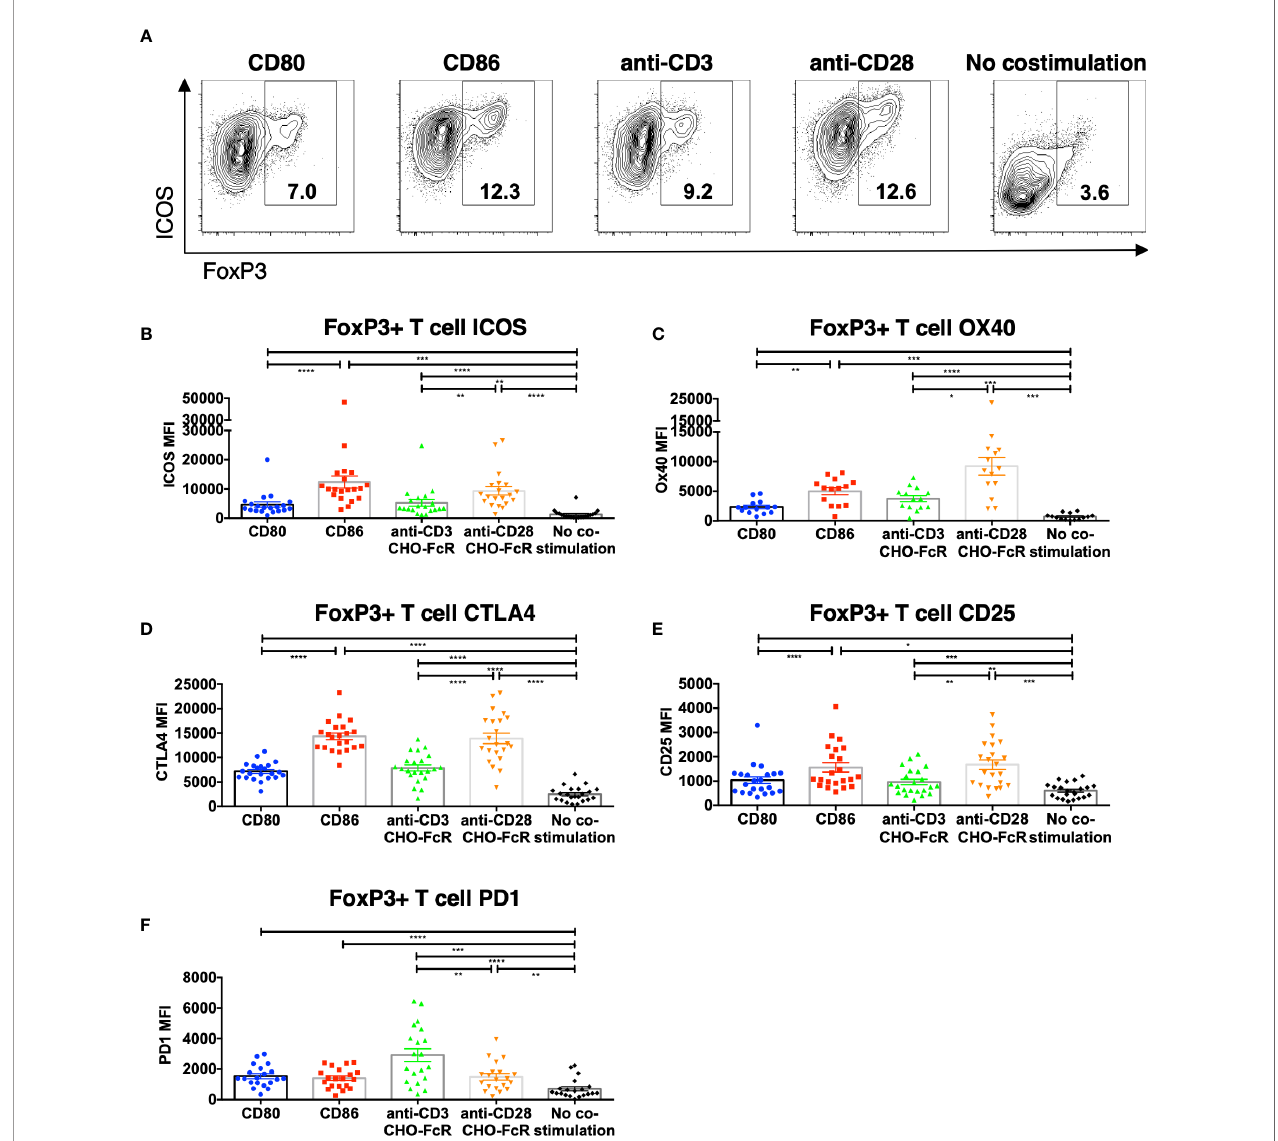
FIGURE 3 | CD86-CD28 costimulation enhances expression of CD25, CTLA-4, OX40 and ICOS. CTV labelled total memory CD4 T cells isolated from healthy donors were cultured for 5 days with CHO-CD80, CHO-CD86 or untransduced CHO (no costimulation), at a ratio of 10 T cells to one CHO cell, with 0.5 m g/ml anti- human-CD3 or with CHO-FcR at 2.5:1 ratio with 1 m g/ml anti-human-CD3 or anti-human-CD28. After 5 days levels of (A, B) ICOS, (C) OX40, (D) CTLA4, (E) CD25 and (F) PD1 in divided CD4+FoxP3+ T cells were assessed by fl ow cytometry. (A) representative fl ow cytometry plots showing ICOS expression. (B – F) aggregate data from 22 independent experiments. One-way ANOVA with Tukey ’ s multiple comparisons tests: *p ≤ 0.05, **p ≤ 0.01, ***p ≤ 0.001, ****p ≤